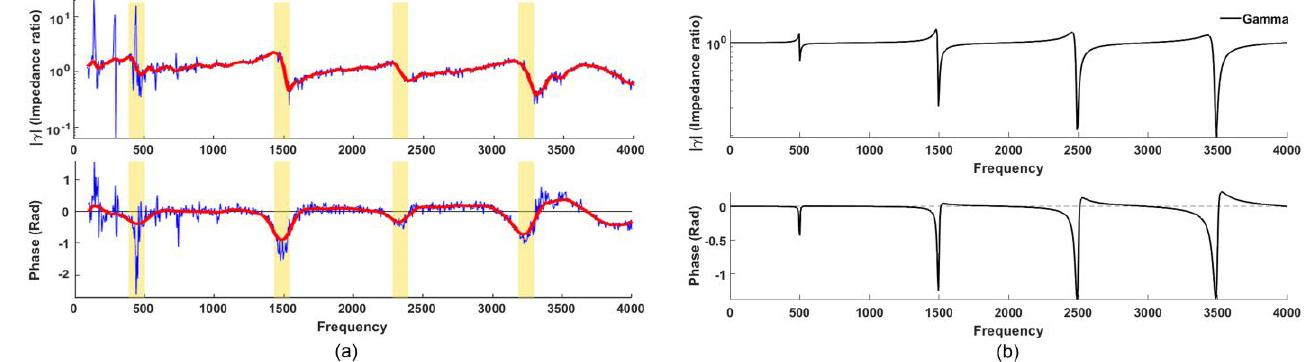
Figure 2. ( a ) Experimental γ(f) measured while phonating the neutral vowel /ə/ (in the target word “herd”), magnitude (above), and phase (below). Blue line shows the raw measurement, while the red line shows the smoothed with Savitsky – Golay algorithm [14] and interpolated spectra (having removed harmonics of the voice), revealing vocal tract resonances as “notches” (magnitude spectrum) and “dips” (phase spectrum), indicated by yellow vertical bands; ( b ) corresponding analytical γ(f) spectra modeled for an ideal baffled open-closed cylinder with a length of 170 mm; the “notches” and “dips” correspond closely in frequency and general structure with the experimental spectra in ( a ).